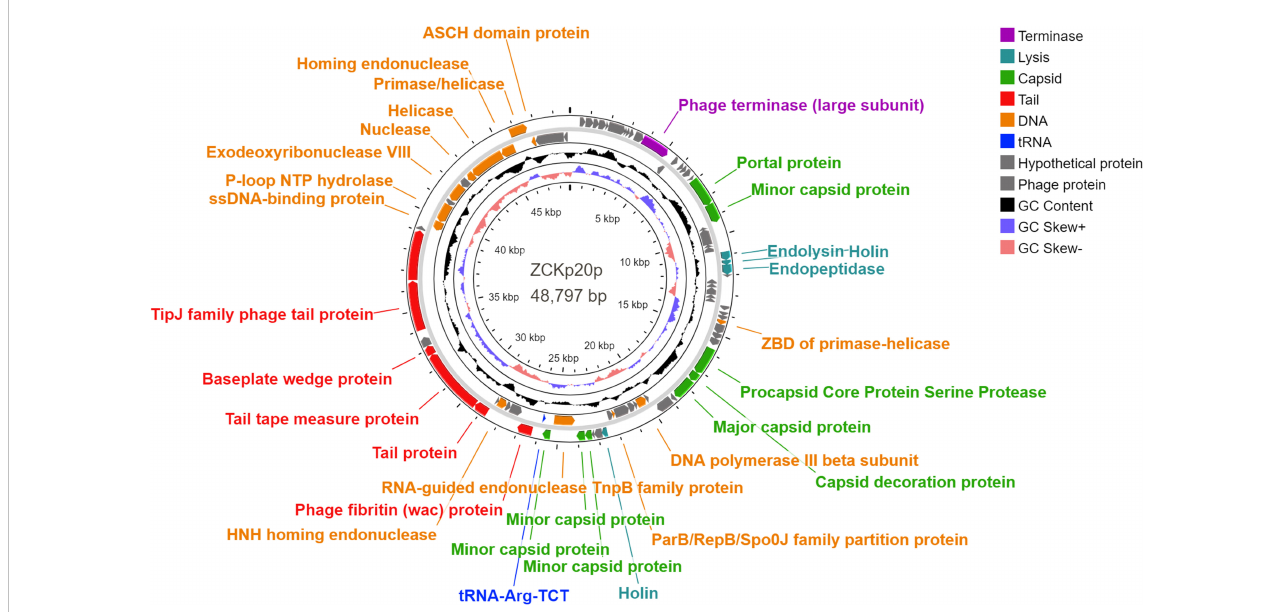
FIGURE 8 Genomic circular map of phage vB_Kpn_ZCKp20p. Different colors represent the coding sequences (CDS) according to the category of the predicted function: terminase (violet); lytic enzymes (turquoise); capsid proteins (green); tail proteins (red); DNA metabolism, replication and repair-related proteins (orange); tRNA gene (blue); phage and hypothetical proteins (grey). The GC content skew is represented in the middle circle with black color. The inner circle represents the GC skew in light blue and light red colors for above and below averages,